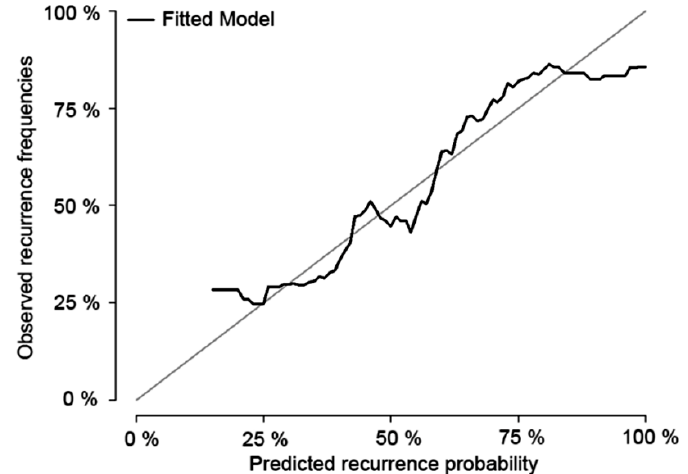
Figure 3. Calibration plot of the nomogram. One thousand bootstrap resamplings were used to validate the established nomogram. The concordance index (c-index) was 0.665 (95% confidence interval [CI], 0.637–0.695), and the incremental area under curve was 0.655 (95% CI, 0.631–0.682).